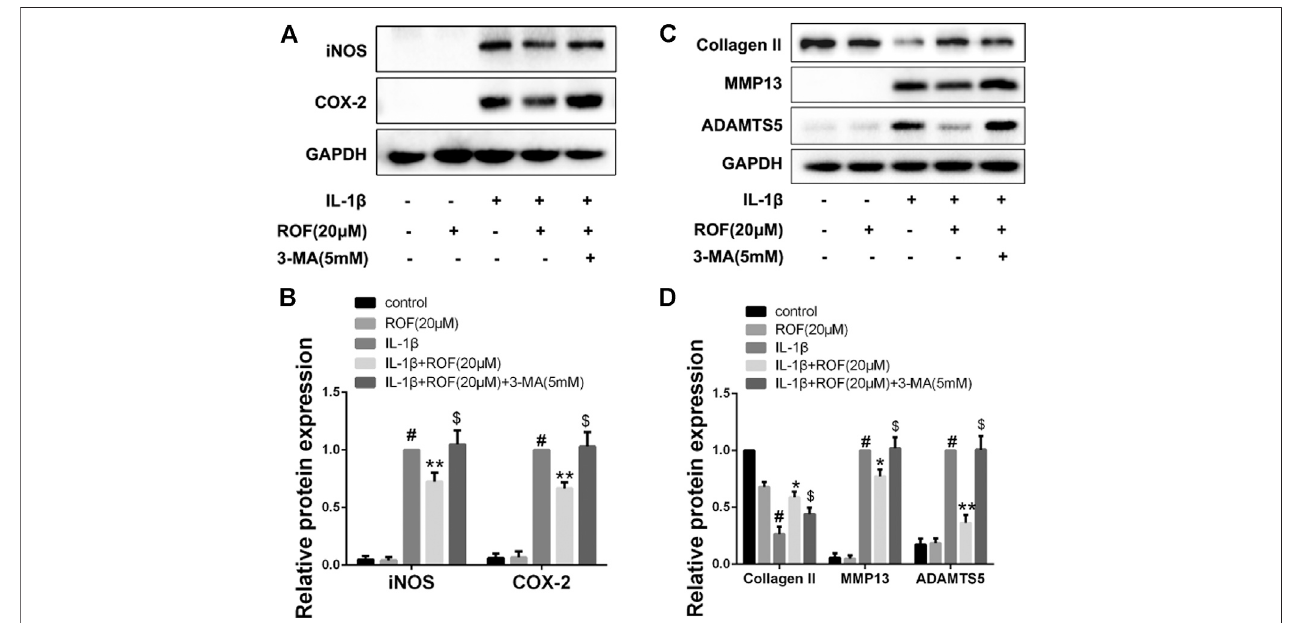
FIGURE 4 | Autophagy inhibitor 3-MA attenuates the anti-in fl ammatory and anti-cartilage degradation effects of ROF in chondrocytes. (A) Western blots and (B) quantitative analysis of iNOS and COX-2 in each group. (C) Western blots and (D) quantitative analysis of collagen Ⅱ , MMP13, and ADAMTS5 in each group. GAPDH was employed as the internal control ( n (cid:2) 3). # p < 0.05 vs. control group; * p < 0.05 and ** p < 0.01 vs. IL-1 β group ； $ p < 0.05 vs. IL-1 β + ROF (20 μ M)